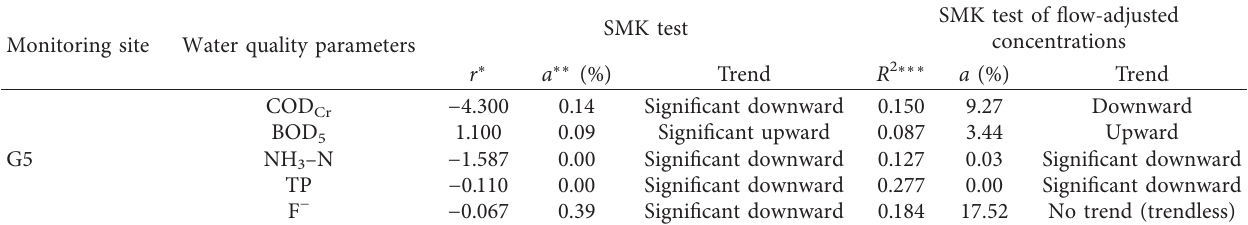
Table 6: Results of the seasonal Mann–Kendall test and the seasonal Mann–Kendall test of flow-adjusted concentrations. Monitoring site